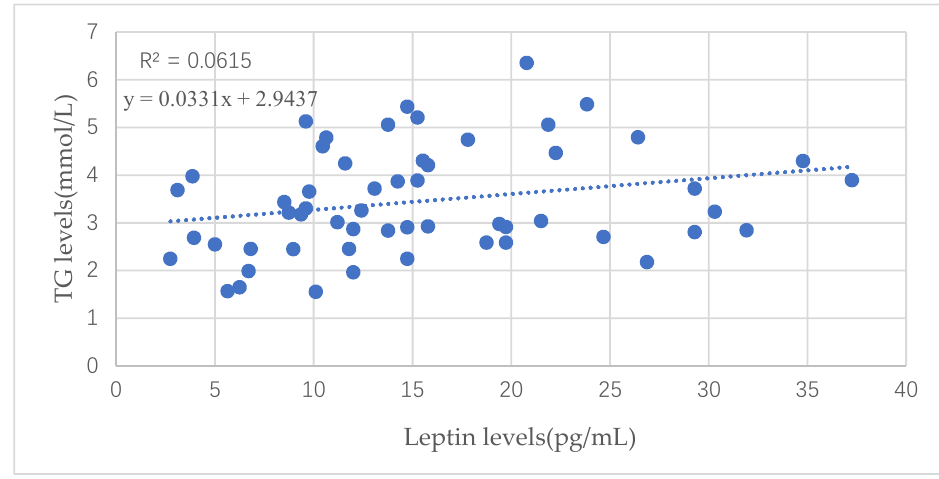
Figure 1. Correlation between leptin in cord blood and TG levels of pregnant women. Leptin in cord blood was positively related to newborns’ birth weight ( p < 0.001), shown in Figure 2, but was not directly related to infants’ weight at six months and one year old ( p > 0.05, not shown in figures below).